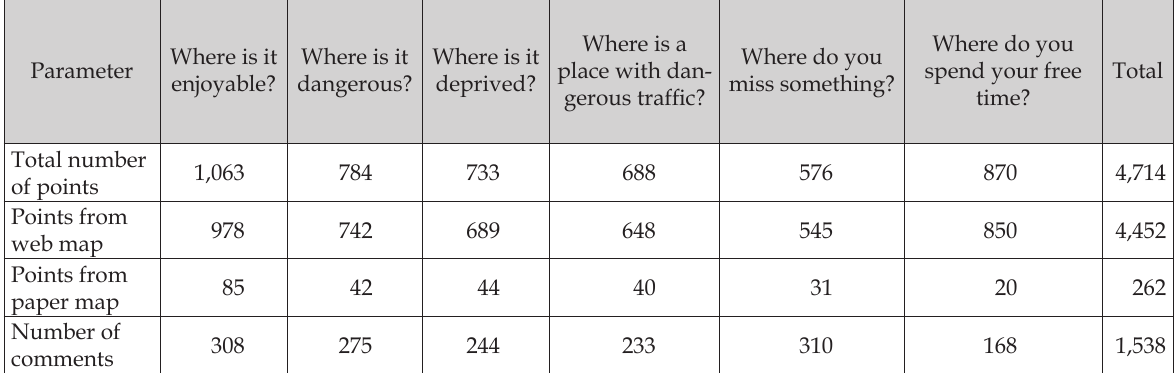
Table 1. Basic statistics from the participatory mapping